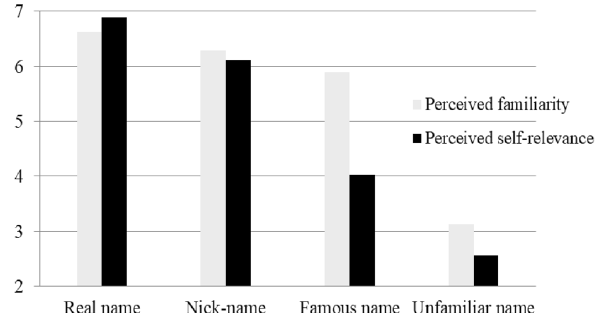
Figure 2. The perceived familiarity and self-relevance for different names.